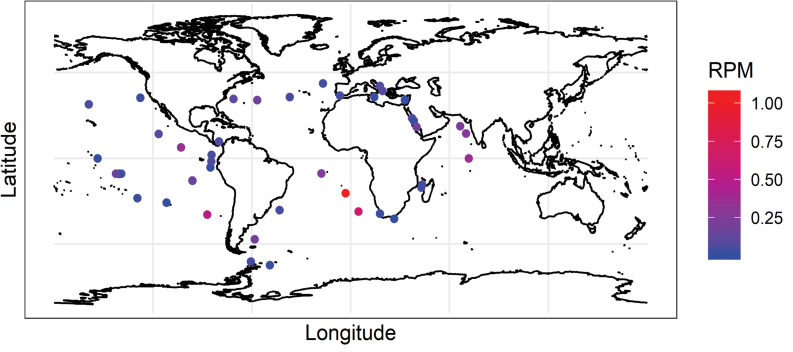
Heatmap of the global distribution of T6SS hcp and vgrg gene sequences.Reads per million (rpm) mapped reads taken from TARA Oceans metagenome dataset. Hotspots of T6SS abundance appear in the South Atlantic and Indian Ocean gyres, known areas with extremely low biomass and low nutrient concentration. Reads matching known hcp and vgrg gene sequences were acquired using BLAST+ 2.9.0. Map was built using data from R Natural Earth. Code is available at https://github.com/M-Kempnich/Presence-and-abundance-of-T6SS.